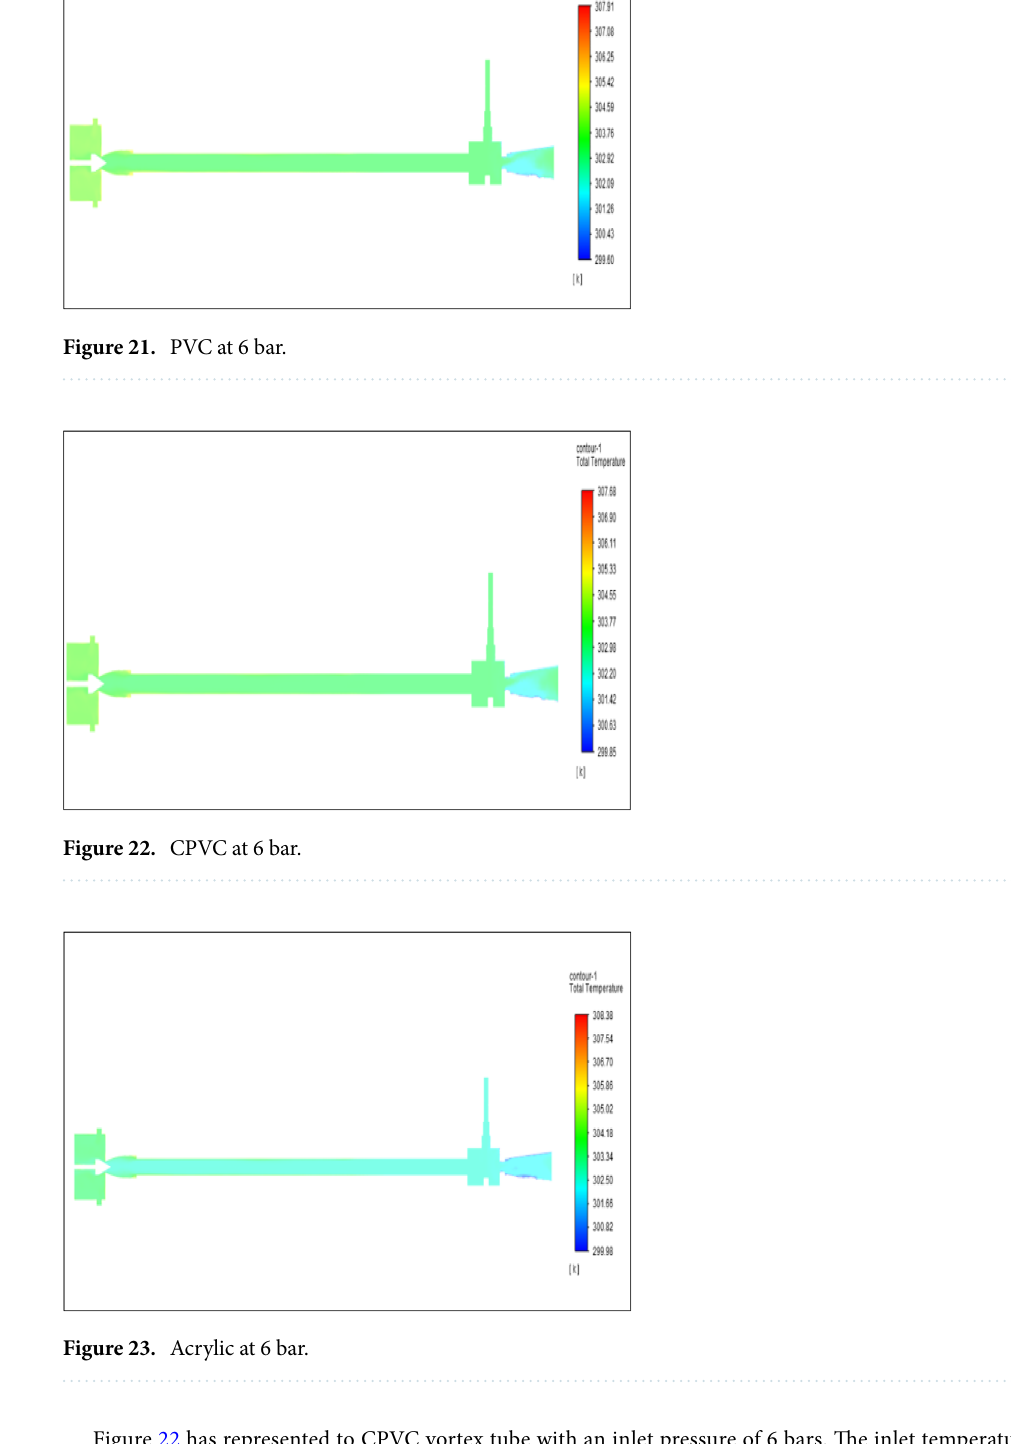
Figure 22 has represented to CPVC vortex tube with an inlet pressure of 6 bars. The inlet temperature of the VT is 303 K. The hot air temperature was obtained at the hot end as 307.02 K. Similarly at the cold end side obtained value was 300.19 K. The maximum temperature difference was found to be 6.82 K. Figure 23 has represented to acraulic vortex tube with an inlet pressure of 6 bars. The inlet temperature of the VT is 303 K. The hot air temperature was obtained at the hot end as 307.51 K. Similarly at cold the end side obtained a value of 300.67 K. The maximum temperature difference was noticed as 6.84 K.